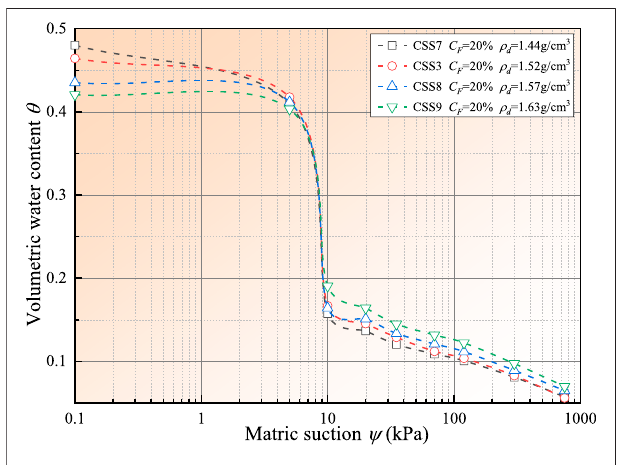
FIGURE 6 | Volumetric water content versus matric suction for calcareous silty sands with different dry